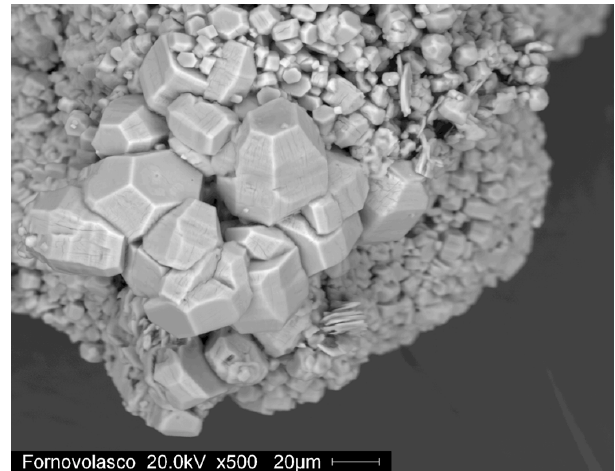
Figure 7. Coquimbite from the Fornovolasco mine, as pseudohexagonal bipyramidal crystals.